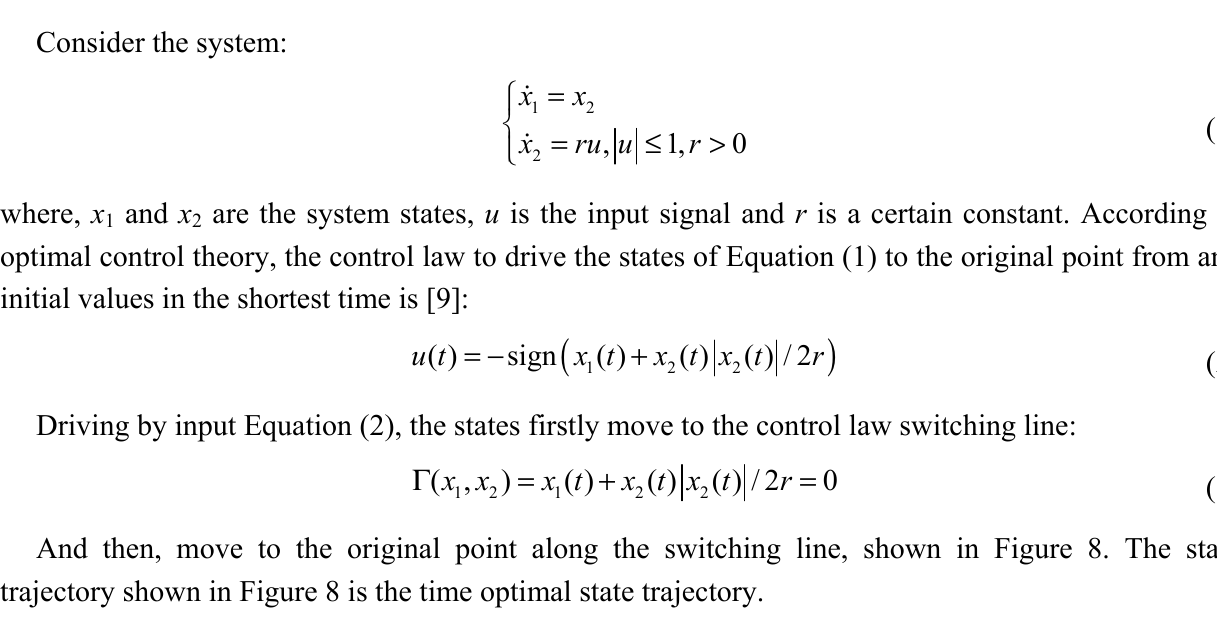
Figure 8. The state trajectory of Equations (1) and